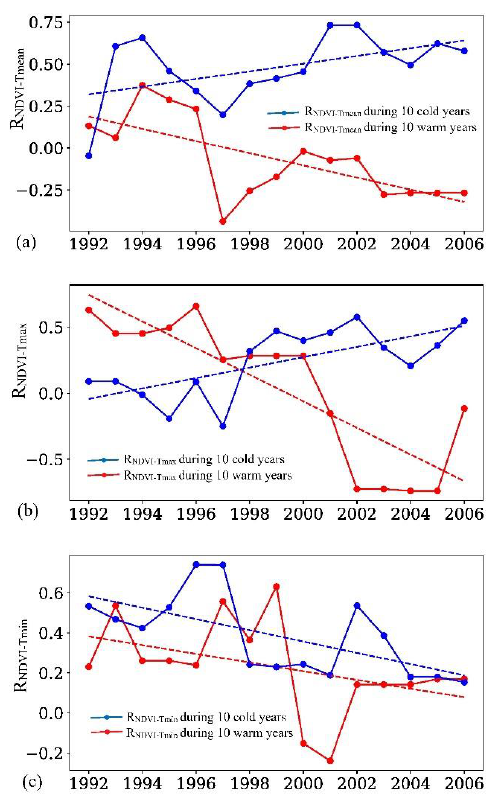
Figure 6. Changes in R NDVI−T (include R NDVI−Tmean , R NDVI−Tmax , and R NDVI−Tmin , represent the partial correlation between NDVI and T mean , T max , and T min , respectively) over the TC in warm and cold years. Year on the horizontal axis is the central year of each 20−year moving window used to derive R NDVI−T (for example, 1992 represents period 1982–2001 in the 20−year time window). For each 20−year se-